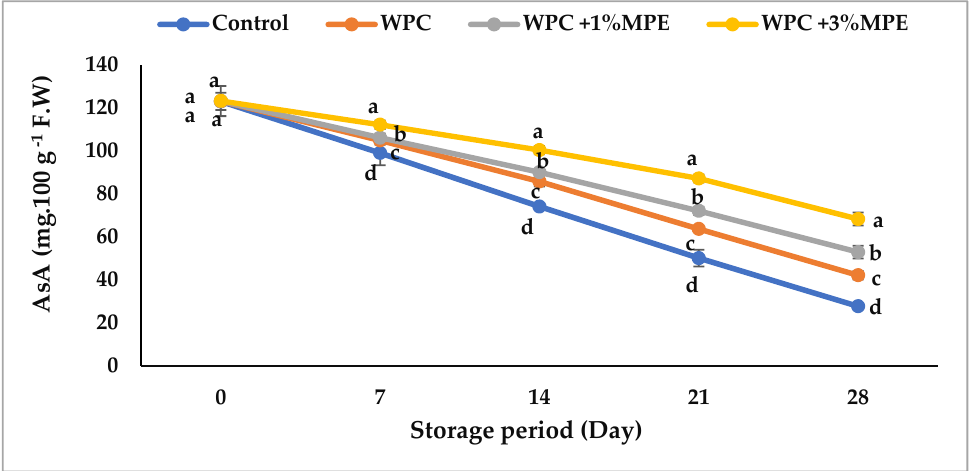
Figure 4. Effect of whey protein concentrate combined with mango peel extract (WPC = whey protein concentrate alone, WPC + 1% MPE = whey protein concentrate + mango peel extract at 1% and WPC + 3% MPE = whey protein concentrate + mango peel extract at 3%) on ascorbic acid (AsA) of broccoli fresh-cuts at 5 ◦ C. Vertical bars indicate standard deviation (n = 6). Means and